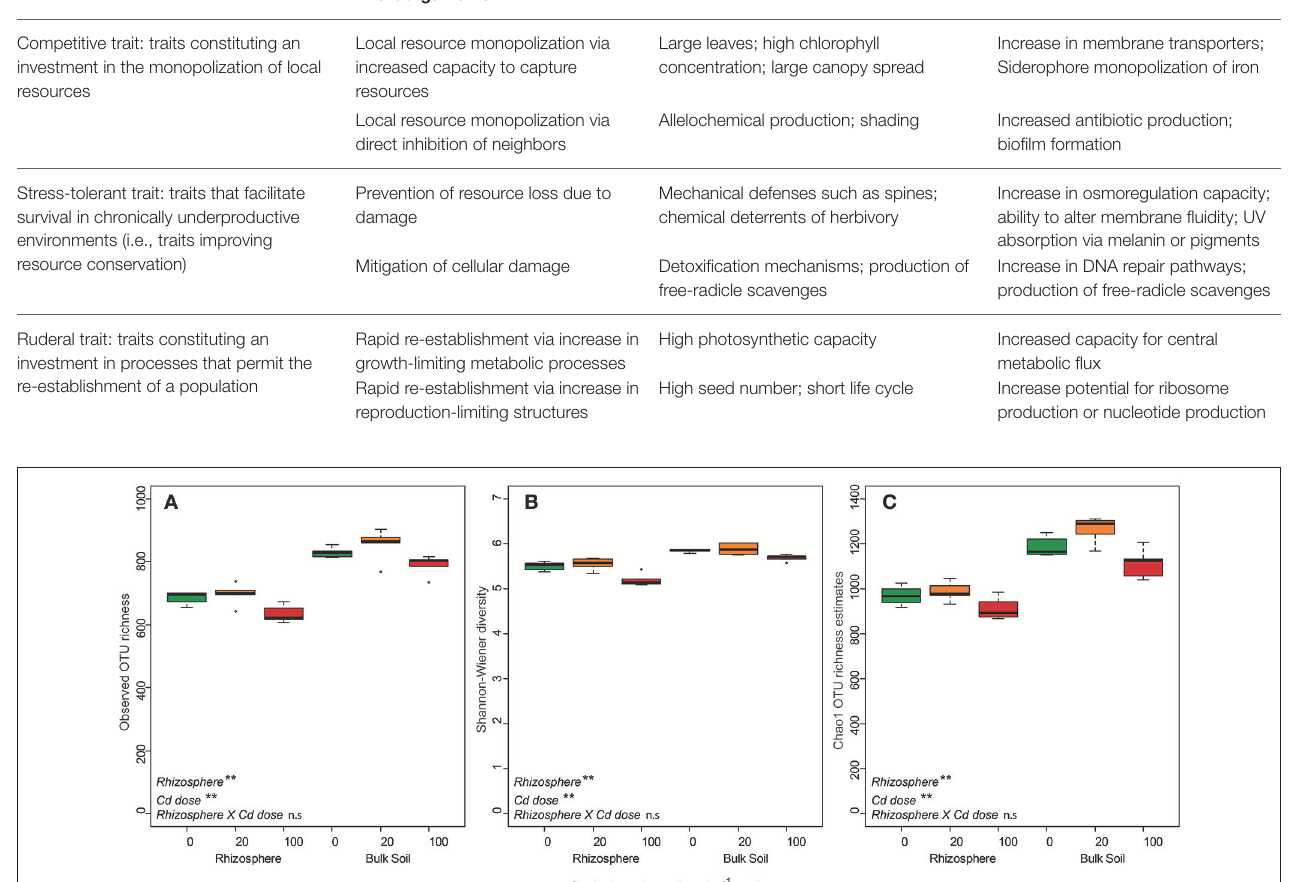
TABLE 1 | Definitions used to define microbial traits as competitive, stress-tolerant or ruderal, adapted from Grime and Pierce (2012). Trait definition